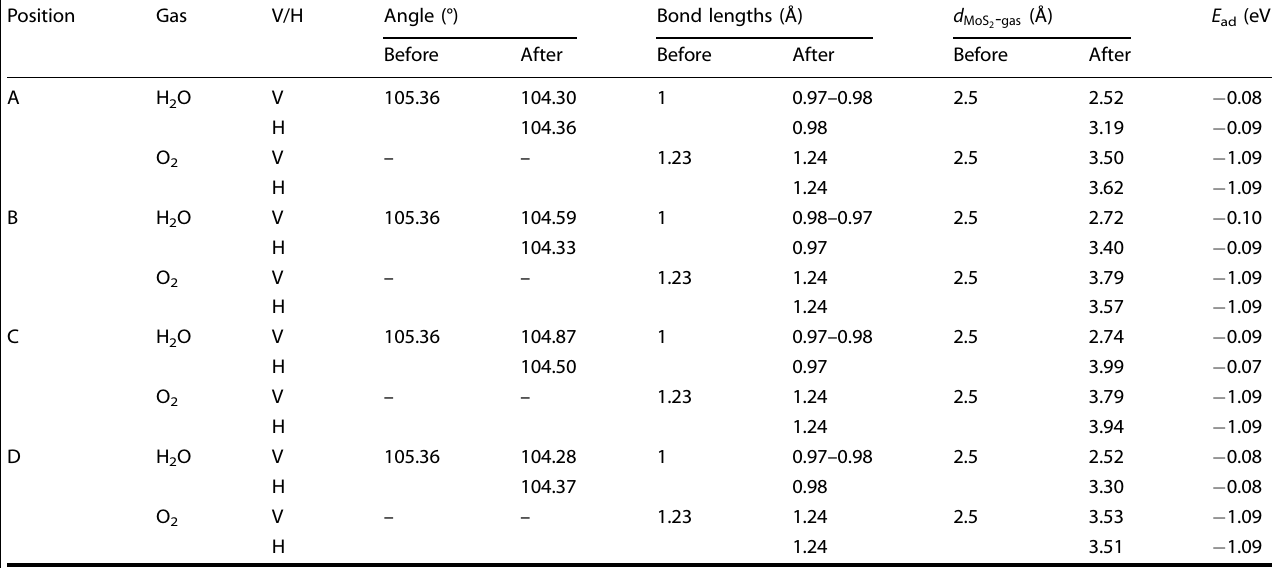
Table 4. Adsorption energies and orientations of adsorbents in the four positions considered.